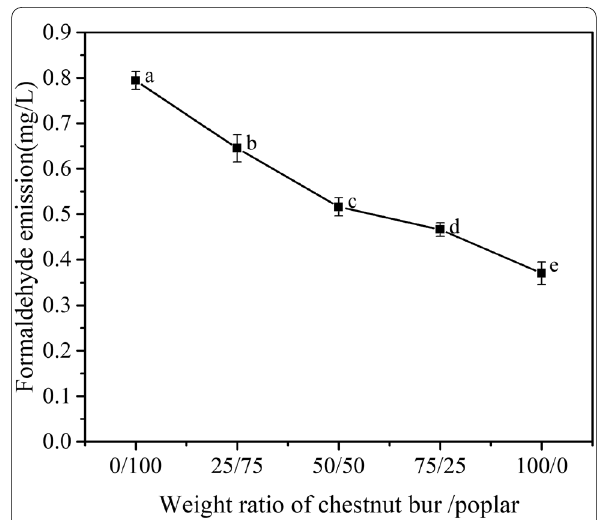
Fig. 8 Formaldehyde emission of composite particleboard. The effect of the weight ratio of chestnut bur /poplar on the formaldehyde emission of particleboard. Error bars indicate standard deviations. Different letters in the figure indicate that means are significantly different ( p <